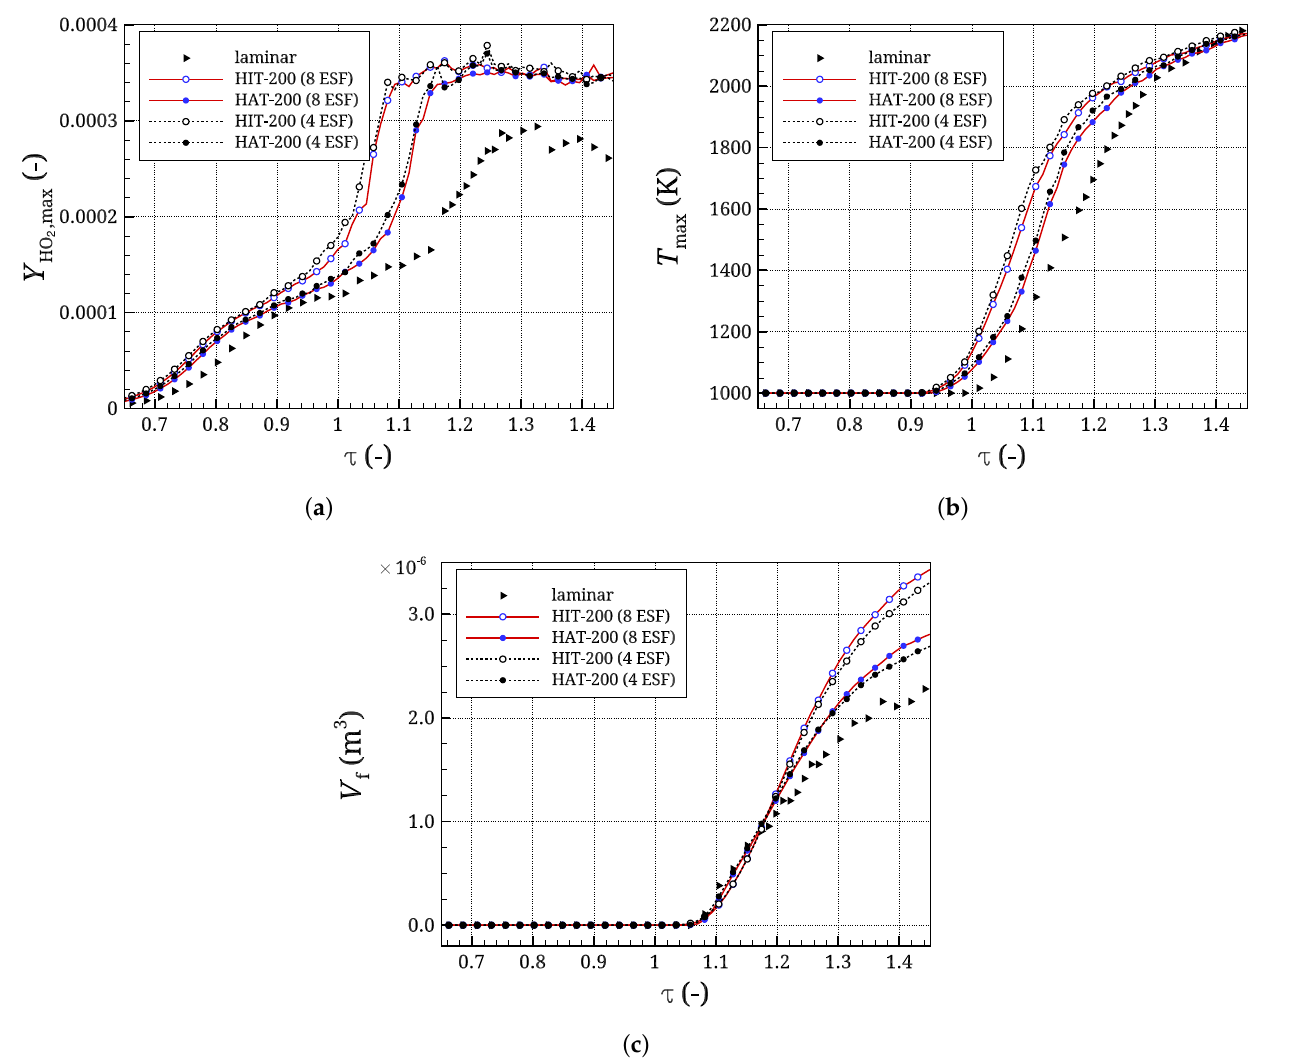
Figure 8. Time evolution of: ( a ) maximum HO 2 concentration; ( b ) maximum temperature; ( c ) flame volume. Comparison of the solutions obtained in laminar and turbulent regimes using different number of stochastic